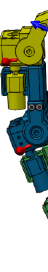
Figure 9. Motion simulation load.